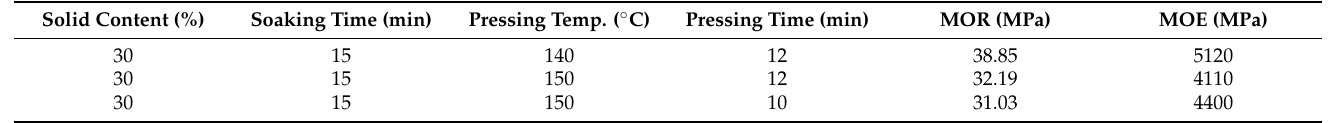
Table 4. Modulus of rupture (MOR) and modulus of elasticity (MOE) of MGE plywood produced using different solid content, soaking time, pressing temperature, and